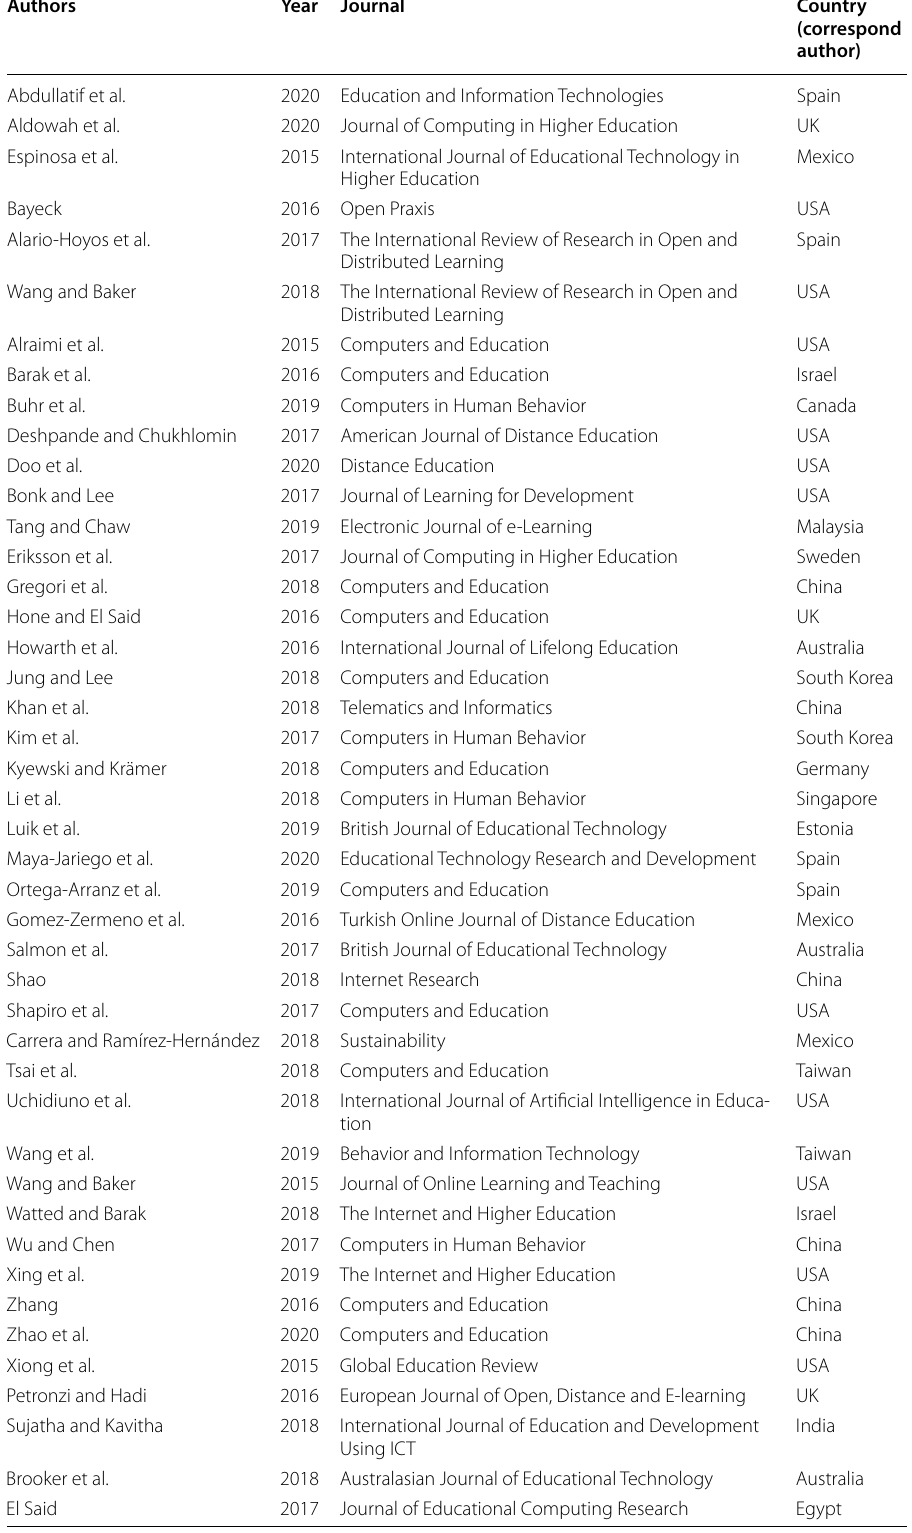
Table 1 Characteristics of the selected studies